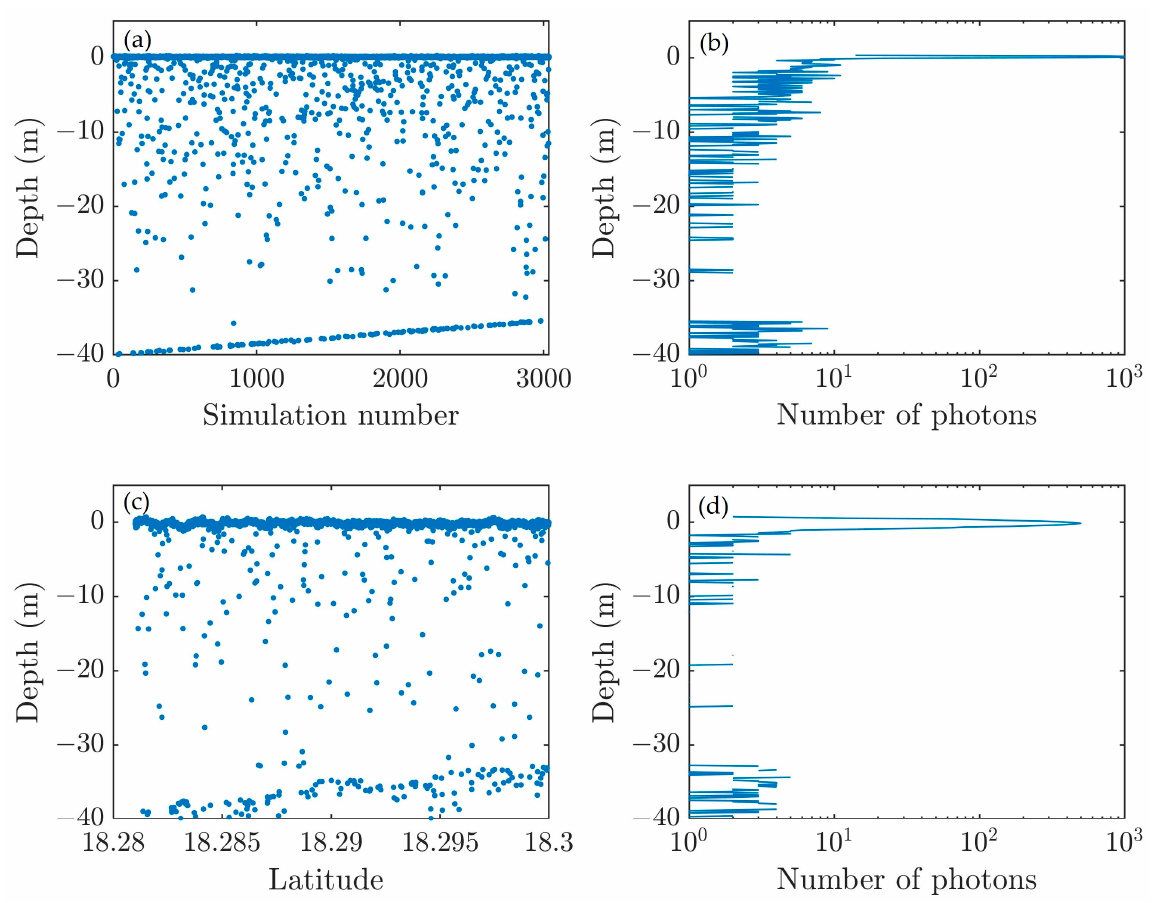
Figure 6. Comparison between simulated results ( a , b ) with ICESat-2 parameters and measured results ( c , d ). The collected photons of the receiver ( a , c ); the integrated number of photons at each depth ( b , d ).